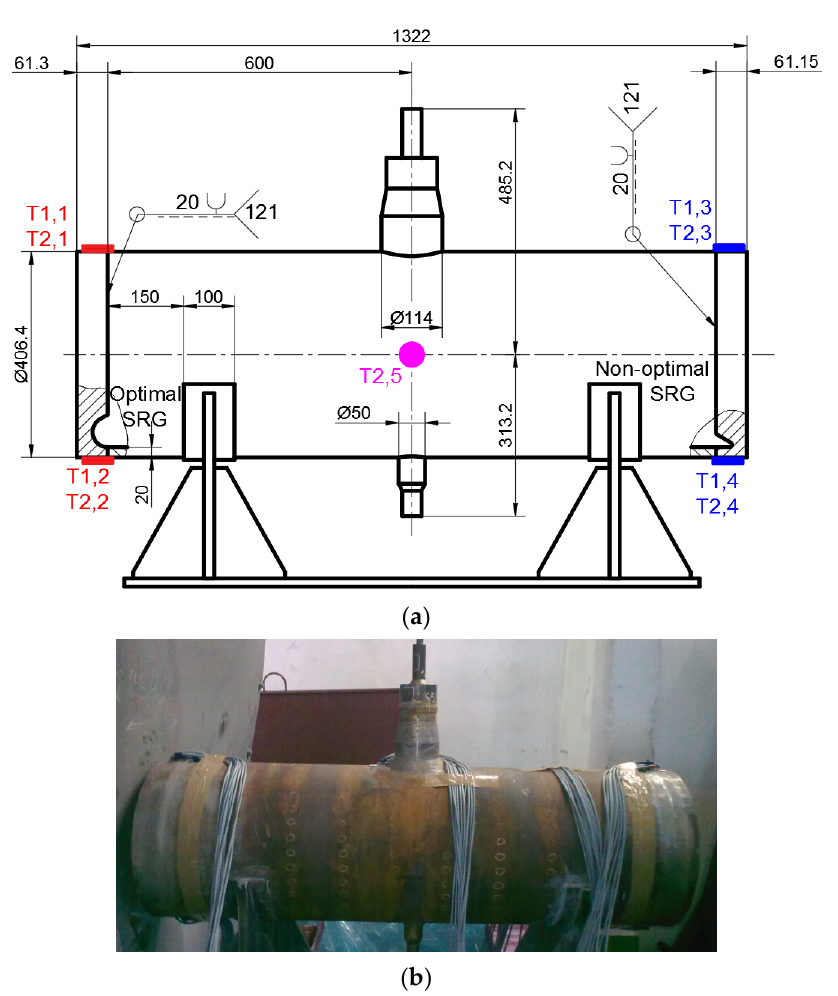
Figure 3. Tested pressure vessel: ( a ) geometry of tested pressure vessel with two different flat ends with marked location of the strain gauges sets (dimensions in mm); ( b ) tested vessel with additional equipment.